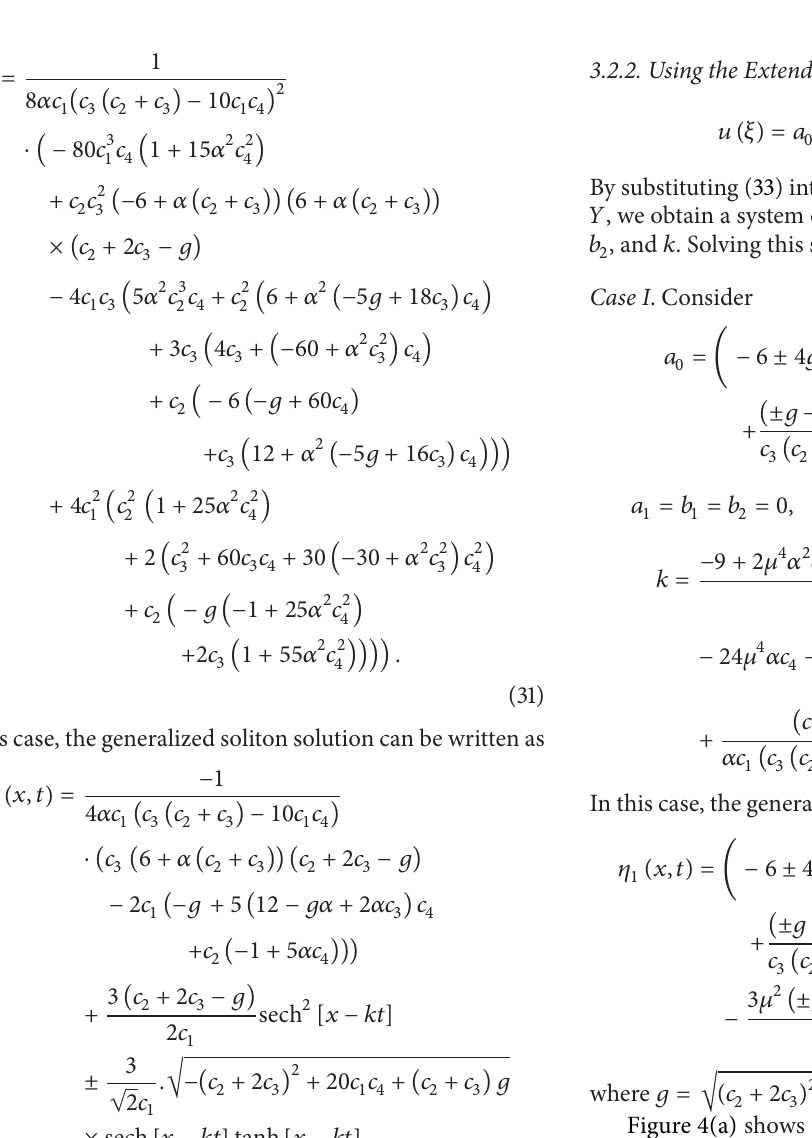
Figure 3: (a) Travelling waves solutions of (28) is plotted: stability bright solitary waves. (b) Travelling waves solutions of (28) is plotted: stability contour of solitary